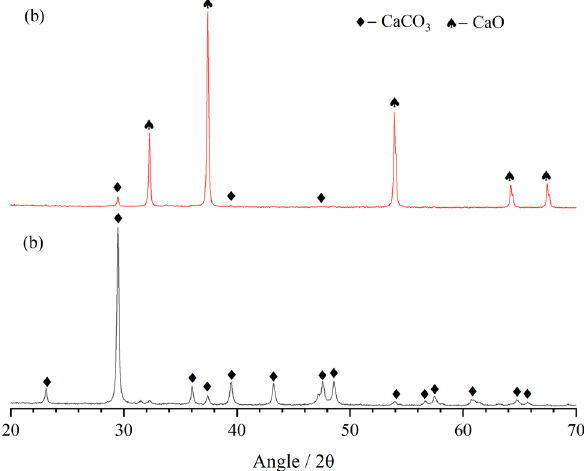
Figure 1: Mineral compositions of the raw materials. ( a ) Lime obtained at 1,350°C for 10 min and ( b ) limestone.